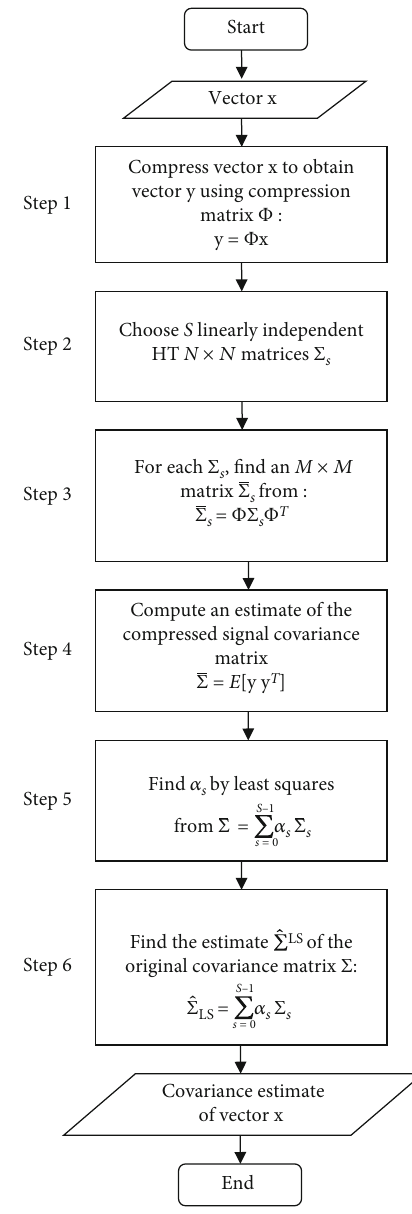
Figure 1: Flowchart of the LS-CCS